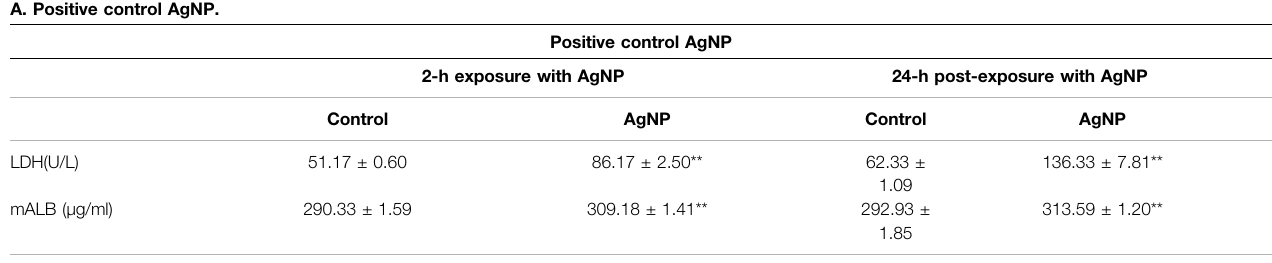
TABLE 6 | Cytotoxicity of 3-D printer emission to A549 cells. Two independent sessions of HIVIS exposure were conducted. A. Positive control